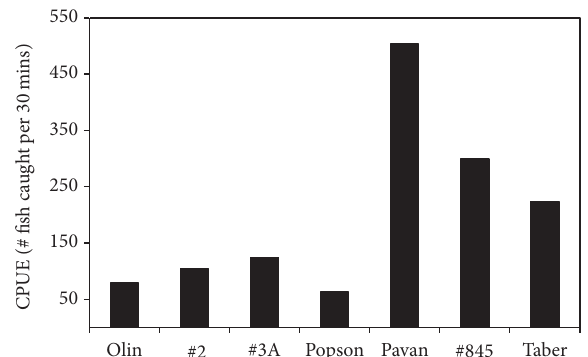
F 2: Catch per unit effort (number of �sh per 30 minutes of electro�shing) of longnose dace ( Rhinichthys cataractae) at each site on the Oldman